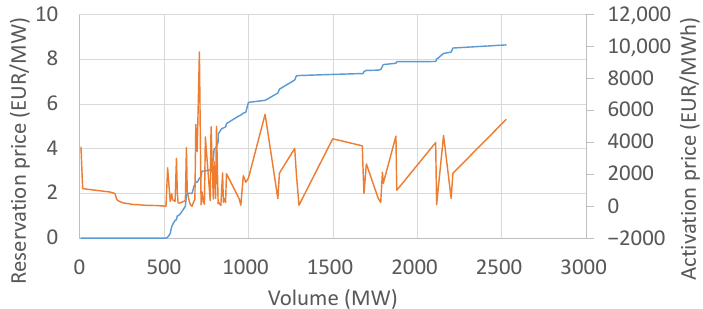
↓ ) and activation ( λ a ↓ t